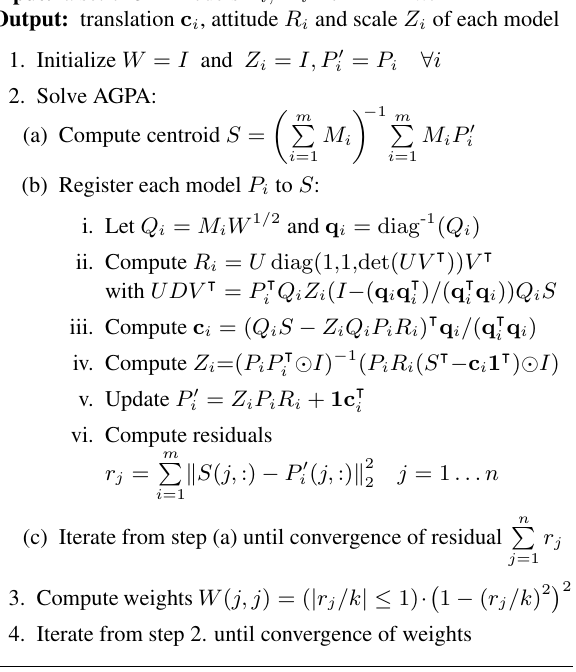
Figure 2. Top: A depiction of a simulated scene (cameras and points) used in the experiment ( m = 16 , n = 192 , d = 10 , p = 36 ); Bottom: the simulated visibility matrix, showing which point (x-axis) is visible in which image (y-axis). The outliers (10) are shown in